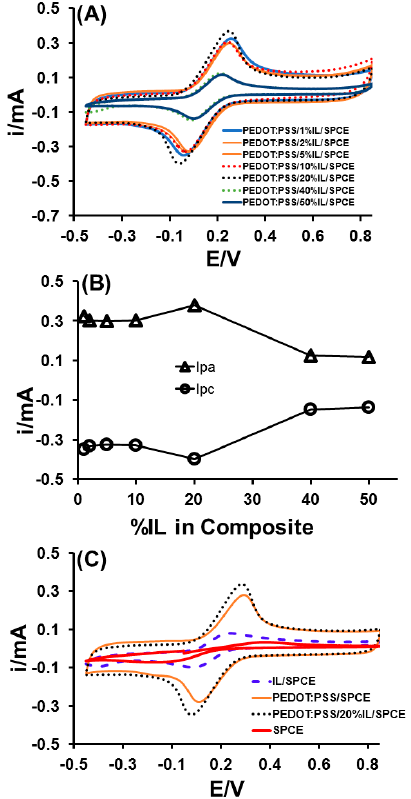
Figure 1. ( A ) Cyclic voltammograms of PEDOT:PSS/IL/SPCE prepared with different amounts